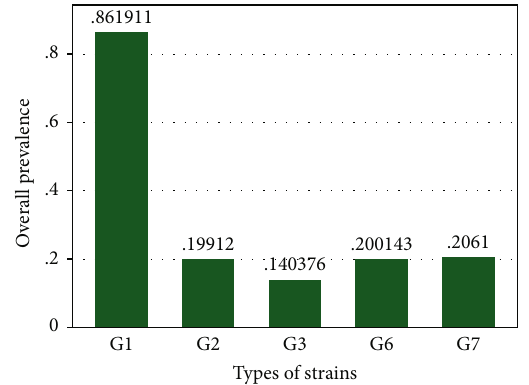
Figure 3: Overall prevalence of di ff erent types of cystic echinococcosis genotypes in Iran (Regardless of their weight in meta-analysis).